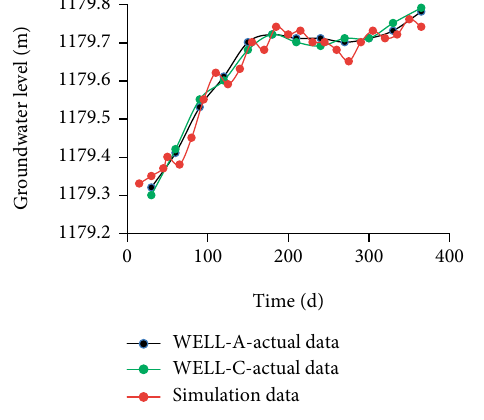
Figure 6: Model veri fi cation results. Table 4: Test error